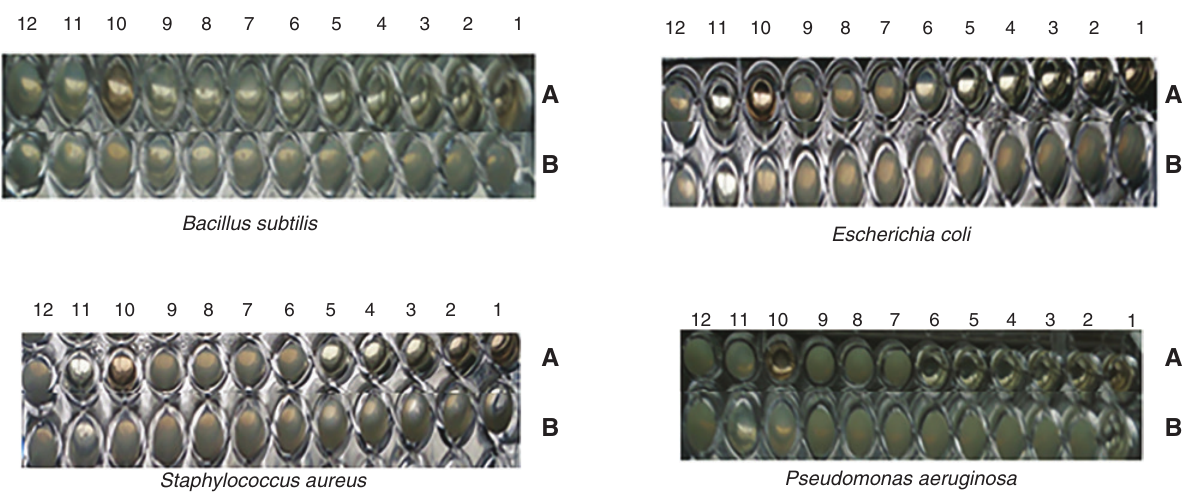
Figure 7: Antibacterial study of silver nanoparticles (AgNPs) on Bacillus subtilis , Escherichia coli , Staphylococcus aureus and Pseudomonas aeruginosa by micro-broth dilution method. (A) Sample, (B) control. Columns 1–9 show the serial